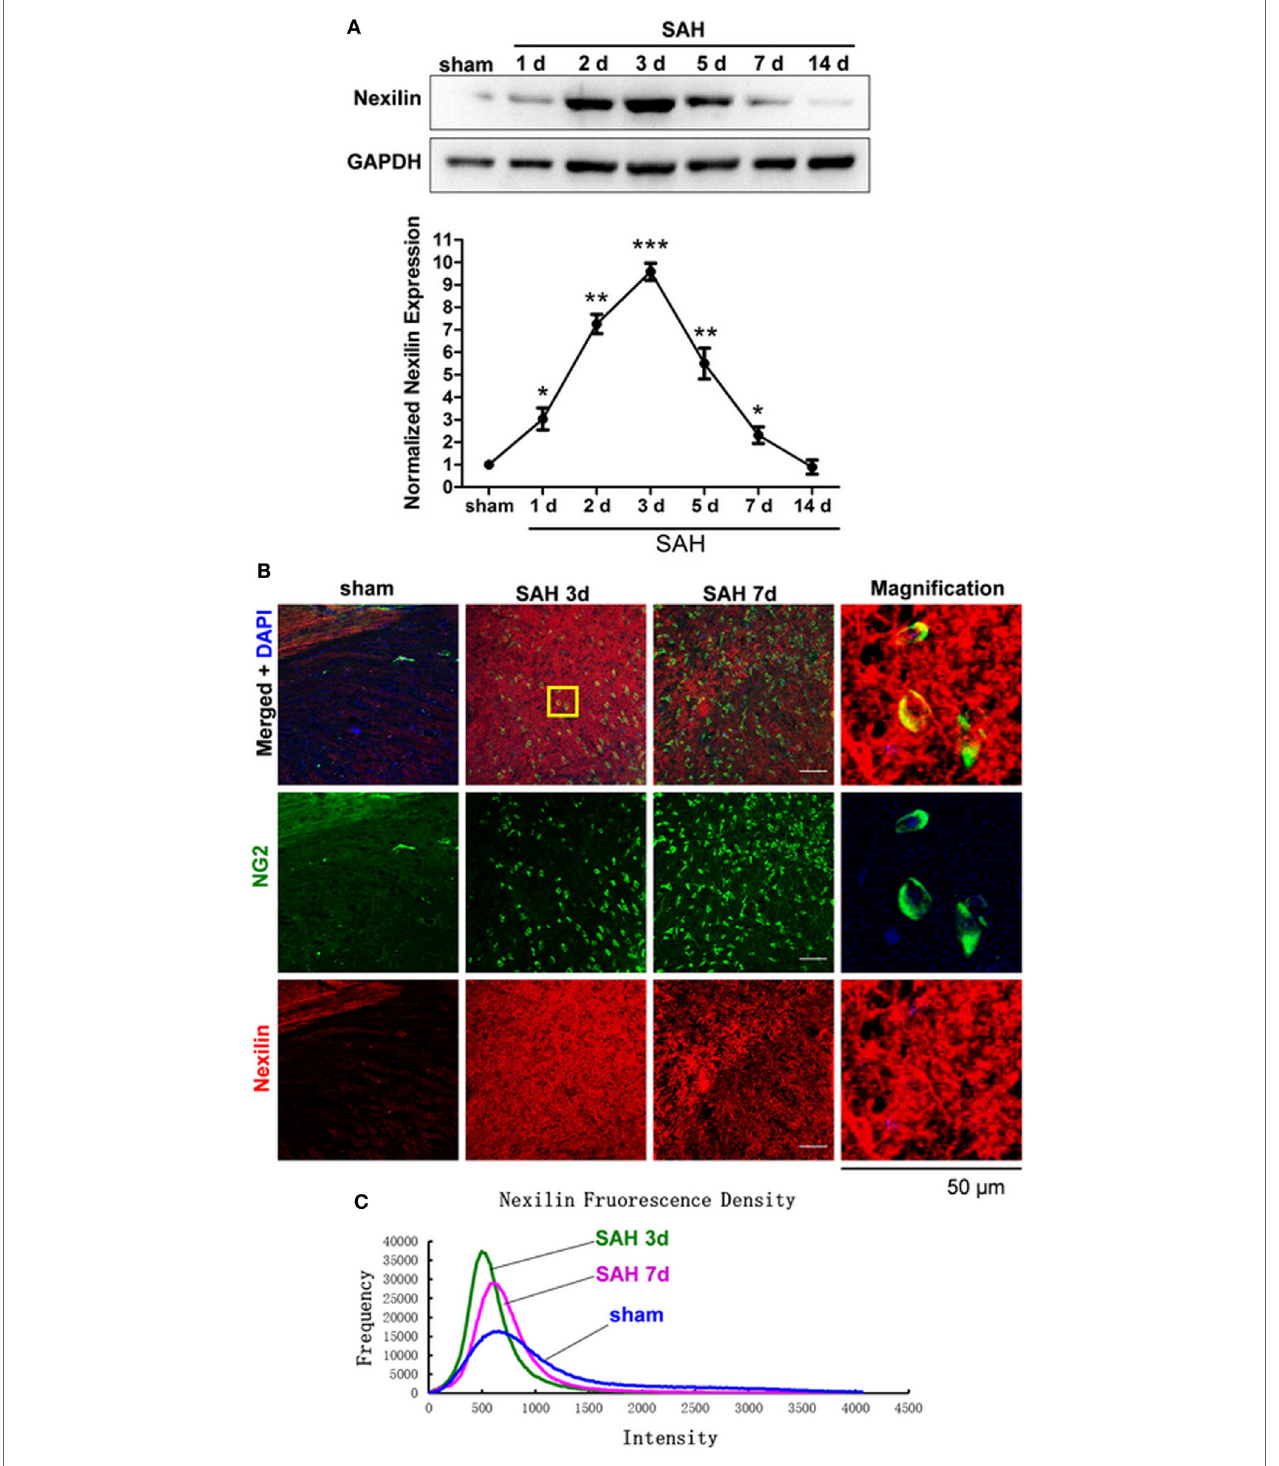
FigUre 2 | Nexilin expression in white matter and oligodendrocyte progenitor cells after SAH. (a) Western blot analysis of nexilin and GAPDH in white matter at 1, 2, 3, 5, 7, and 14 days after SAH. (B) Representative images of NG2- and nexilin-positive apoptotic neurons (20 × ) are shown. The magnified image on the right is enlarged five times. Scale bar = 50 µm. (c) Representative frequency curves of nexilin fluorescence intensities in the sham, SAH 3 days and SAH 7 days groups. The data are presented as the mean ± SEM, n = 6 for each group. * P < 0.05 versus the sham group, ** P < 0.01 versus the sham group, *** P < 0.001 versus the sham group. SAH, subarachnoid